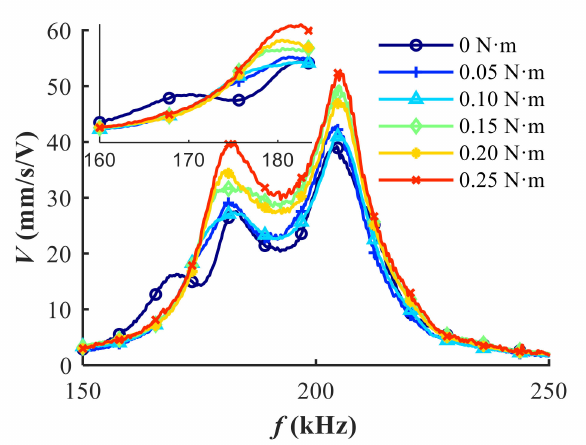
Figure 11. The e ff ect of the pre-tightening force on the vibration velocity of the center on the radiation surface of the